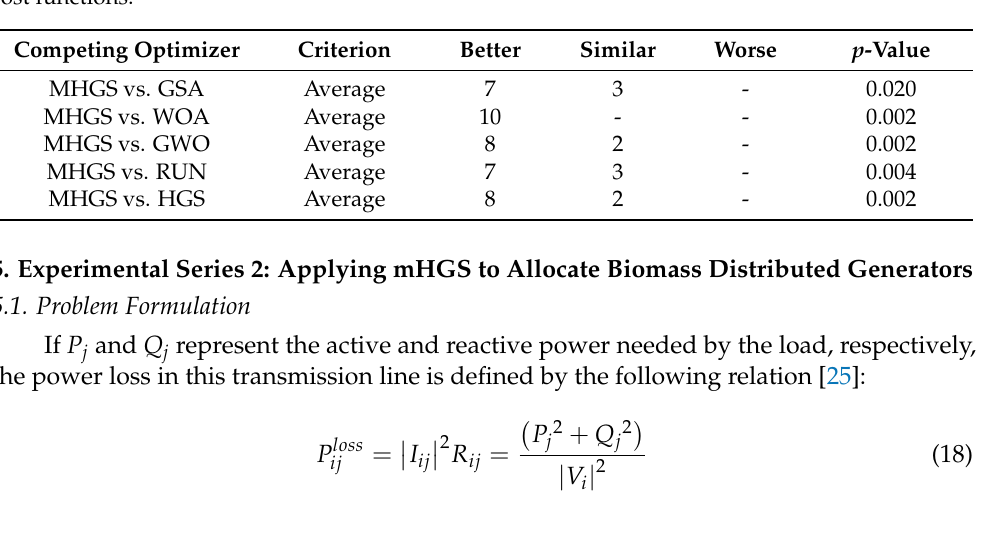
Figure 3. The boxplot plots of the new mHGS and the addressed optimizers over the ten CEC’2020 benchmarks where the dimension is 10. Table 4. The comparison and p -value results based on the Wilcoxon test for the ten CEC’2020 cost